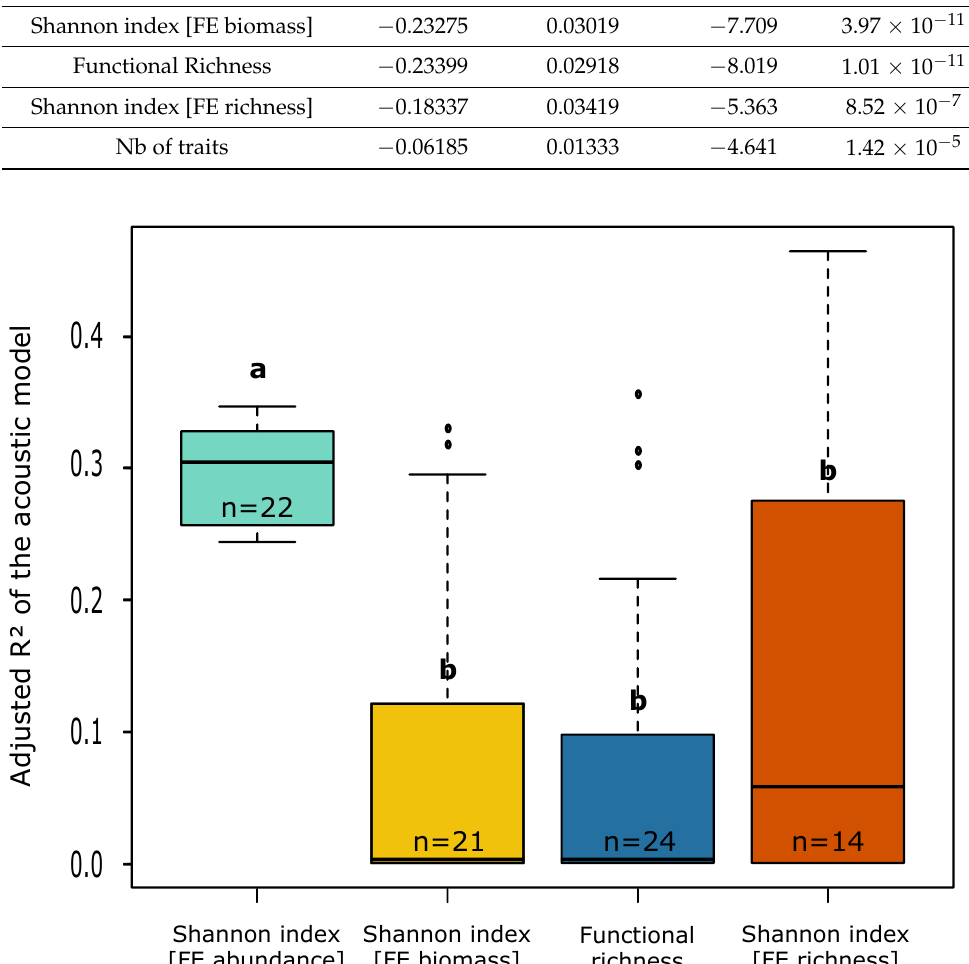
Figure 6. Boxplots representing the dispersion of values for the adjusted R 2 of the acoustic models for each kind of functional descriptor considered in this study. Letters indicate results of Tukey HSD post hoc test. For each kind of descriptor, sample size is